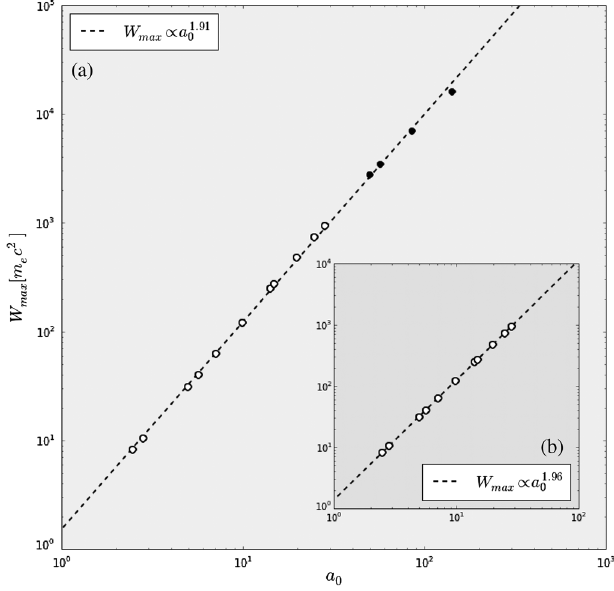
FIG. 5. The energy gain is studied from the region of the ponderomotive acceleration. Log-log plot of max kinetic energy against amplitude a 0 for a positronlike mass ratio. (a) This scaling contains all of the relativistic data points ( a 0 > 1 ). (b) This scaling contains points in the region where a 0 is relativistic, but finite grid effects have a negligible contribution.